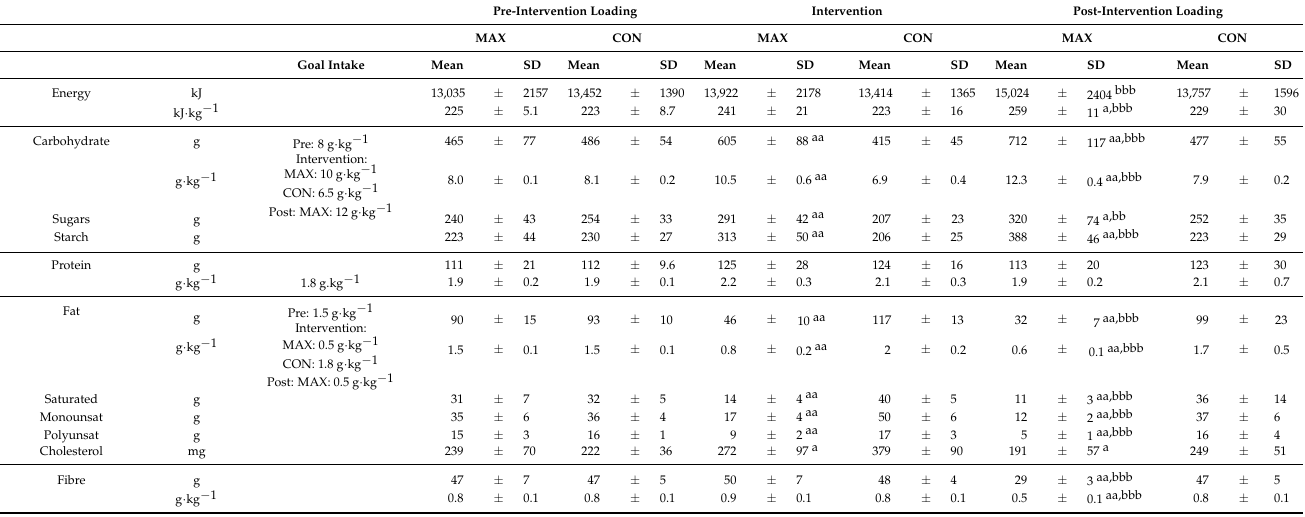
Table 2. Energy and macronutrient intakes during pre-race CHO loading phases (pre- and post- interventions) and a 14-day dietary intervention involving high CHO availability (MAX) versus moderate CHO availability (CON) in highly trained distance runners. Pre-InterventionLoading Intervention Post-InterventionLoading MAX CON